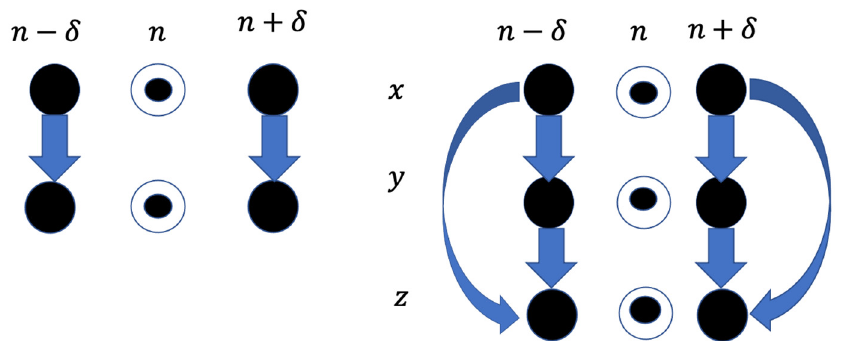
Figure 1. A schematic diagram illustrating the architecture of 2-by-2 and 3-by-3 perfect matrices of Lagrange differences. Zeroth-order differences (the diagonal elements of the matrices) are depicted in circles. First-order differences are depicted by arrows connecting respective elements.